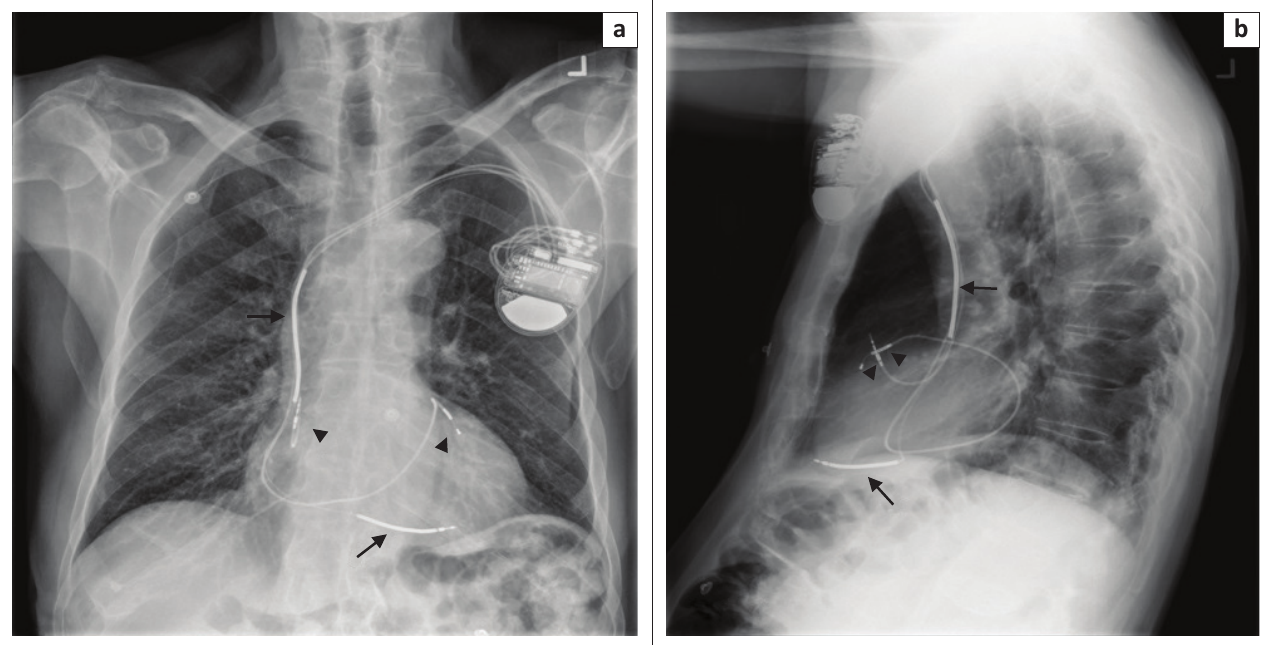
FIGURE 11: Frontal (a) and lateral (b) chest radiographs showing a cardiac resynchronisation therapy device with its pacemaker leads (arrow heads) in the right atrial appendage and the left ventricle, and its implantable cardioverter defibrillator shock coils (arrows) in the superior vena cava and right ventricular apex.